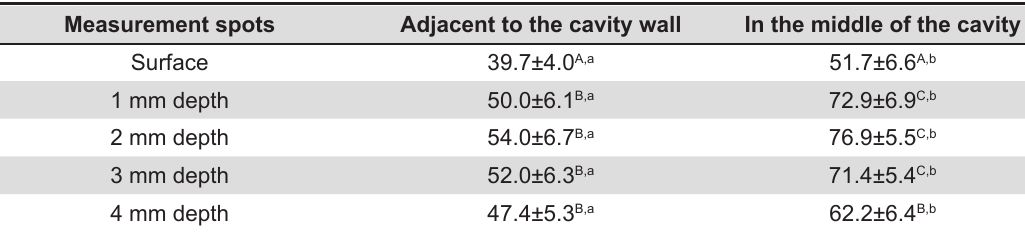
Table 1- Mean and standard deviation values of peak polymerization temperature (°C) of composite resin specimens at the selected